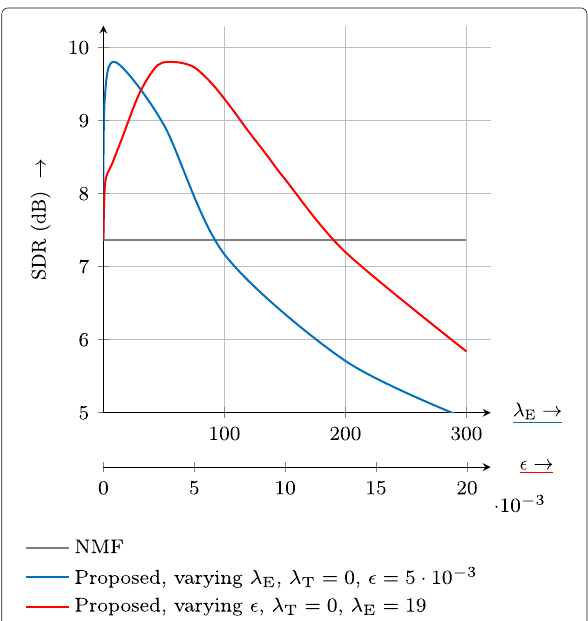
Fig. 8 Performance for varying λ E and (cid:5) . For this experiment, K = 20, K S = 20, SNR = 3 dB is chosen and ego-noise caused by movements of Sequence I is